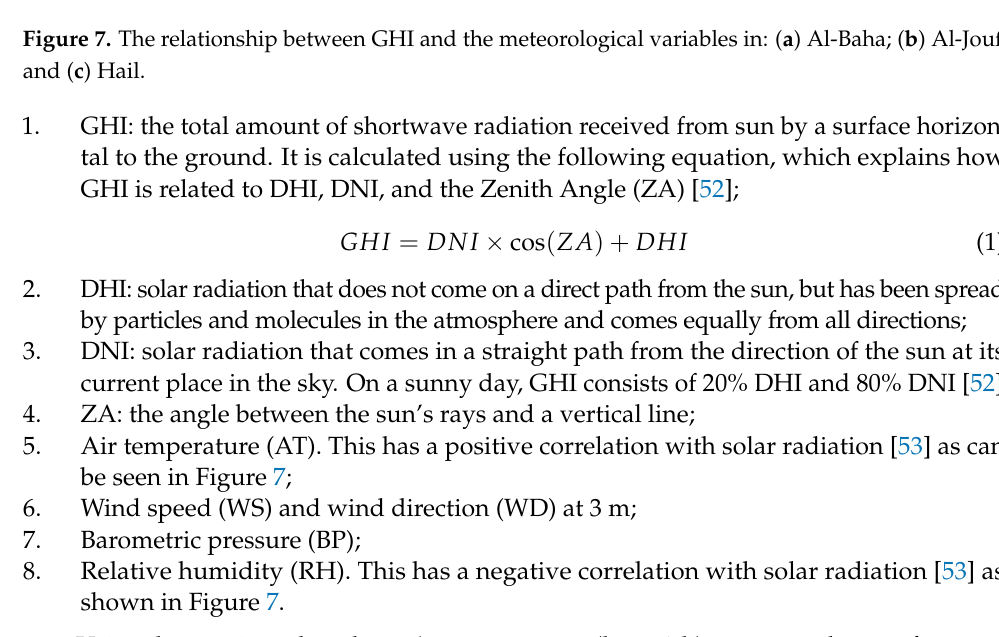
Table 4. Forecasting datasets features.